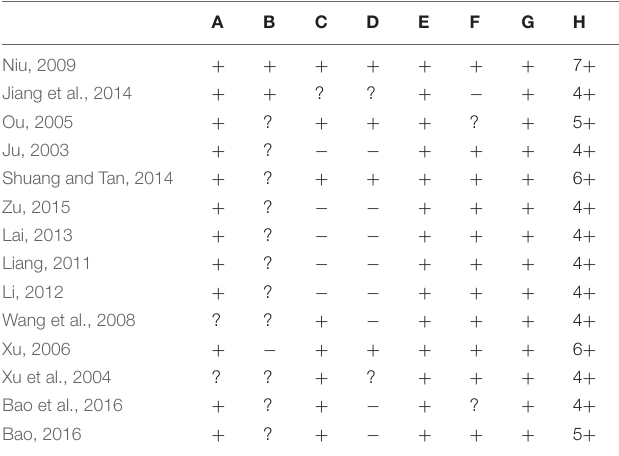
TABLE 3 | The Cochrane Collaboration’s tool for assessing RoB.